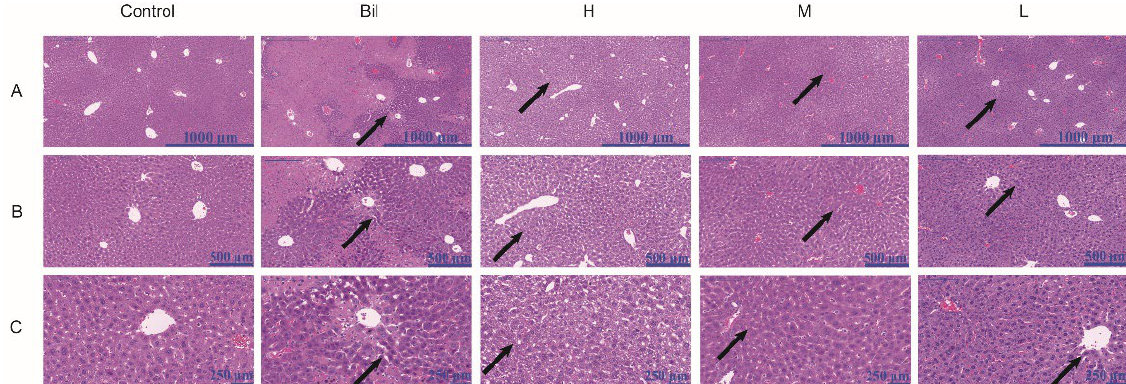
Figure 8. Effects of PGC - CDs on liver pathology in mice. Histological changes of liver obtained from mice of control group (Control), Bil group (Bil), and high (H), medium (M), and low (L) doses of PGC - CDs (5.80, 2.90 and 1.45 mg/kg) in ( A ) magnification at 50×, ( B ) magnification at 100× and ( C ) magnification at 200×.